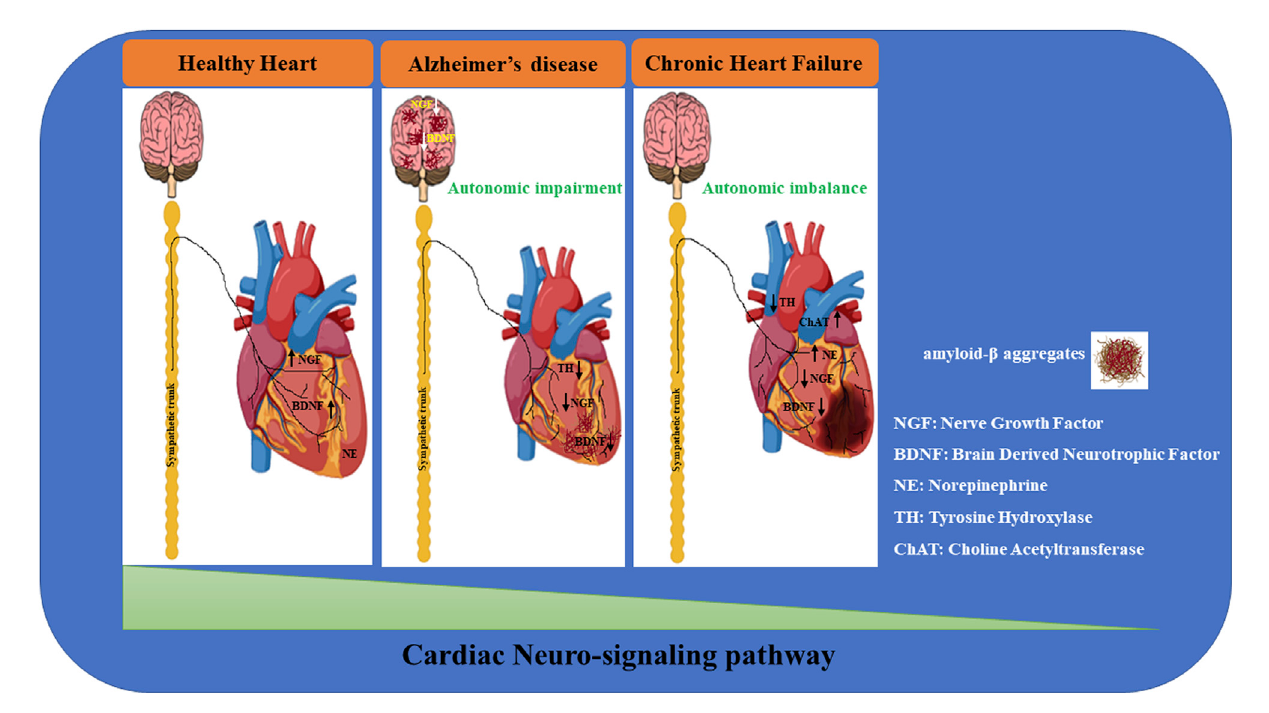
Neuro-signaling pathway dysregulation in relation to the development of heart damage. The gradual loss of neurotrophic factors (i.e.; NGF, BDNF) severely affects the neuro-signaling pathway of the brain/heart axis, increasing the incidence to develop cardiovascular disorders of different etiology. In Alzheimer ’ s disease (AD), amyloid- β accumulation signi fi cantly impacts the expression of neurotrophins, resulting in a maladaptive remodeling of the neuro- signaling pathwaywith adramaticcognitivedecline anddementiadevelopment.Itisreasonableto hypothesize that theprogressive degenerationofthe neuro signaling pathway associated with neuronal impairment observed in the brain of AD patients may trigger a gradual decline in neurotrophic factors circulatinglevels,leadingtoaseverederangementofthecardiacnervoussystem,culminatinginlethalheartdisorders(suchasAF,MI,HF).Duringheartfailure, progressively, the blood pressure drops together with the cardiac output, resulting in brain hypoperfusion, thus leading to sympathetic nervous system hyperactivation. This induces norepinephrine (NE) over-release from sympathetic fi bers, culminating in the upregulation of catecholamine circulating levels. In parallel, neuro-signaling is downregulated in the myocardium (green triangle), with progressive impoverishment of autonomic nerve fi bers, leading to extended myocardial